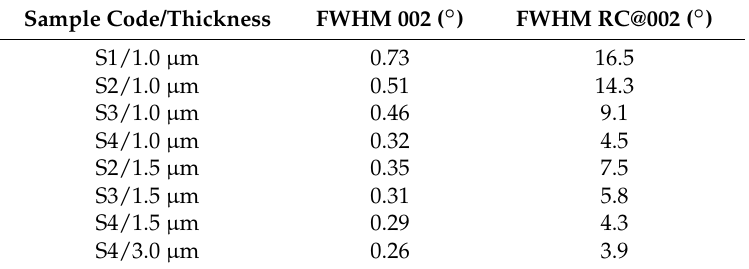
Table 3. FWHM values of the 002 diffraction peaks and their corresponding RCs.